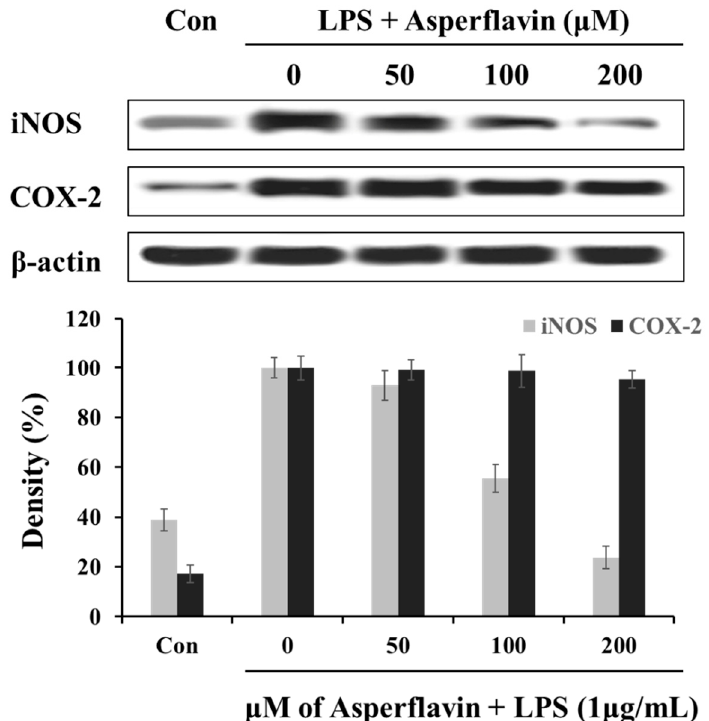
Figure 6. Inhibitory effects of asperflavin on the expression of iNOS and COX-2 in LPS-stimulated RAW 264.7 cells. The RAW 264.7 cells were pre-incubated for 18 h, and stimulated with LPS (1 μ g/mL) for 24 h in the presence of asperflavin (50, 100, and 200 μ M). The expression levels of iNOS and COX-2 were determined using immunoblotting method.